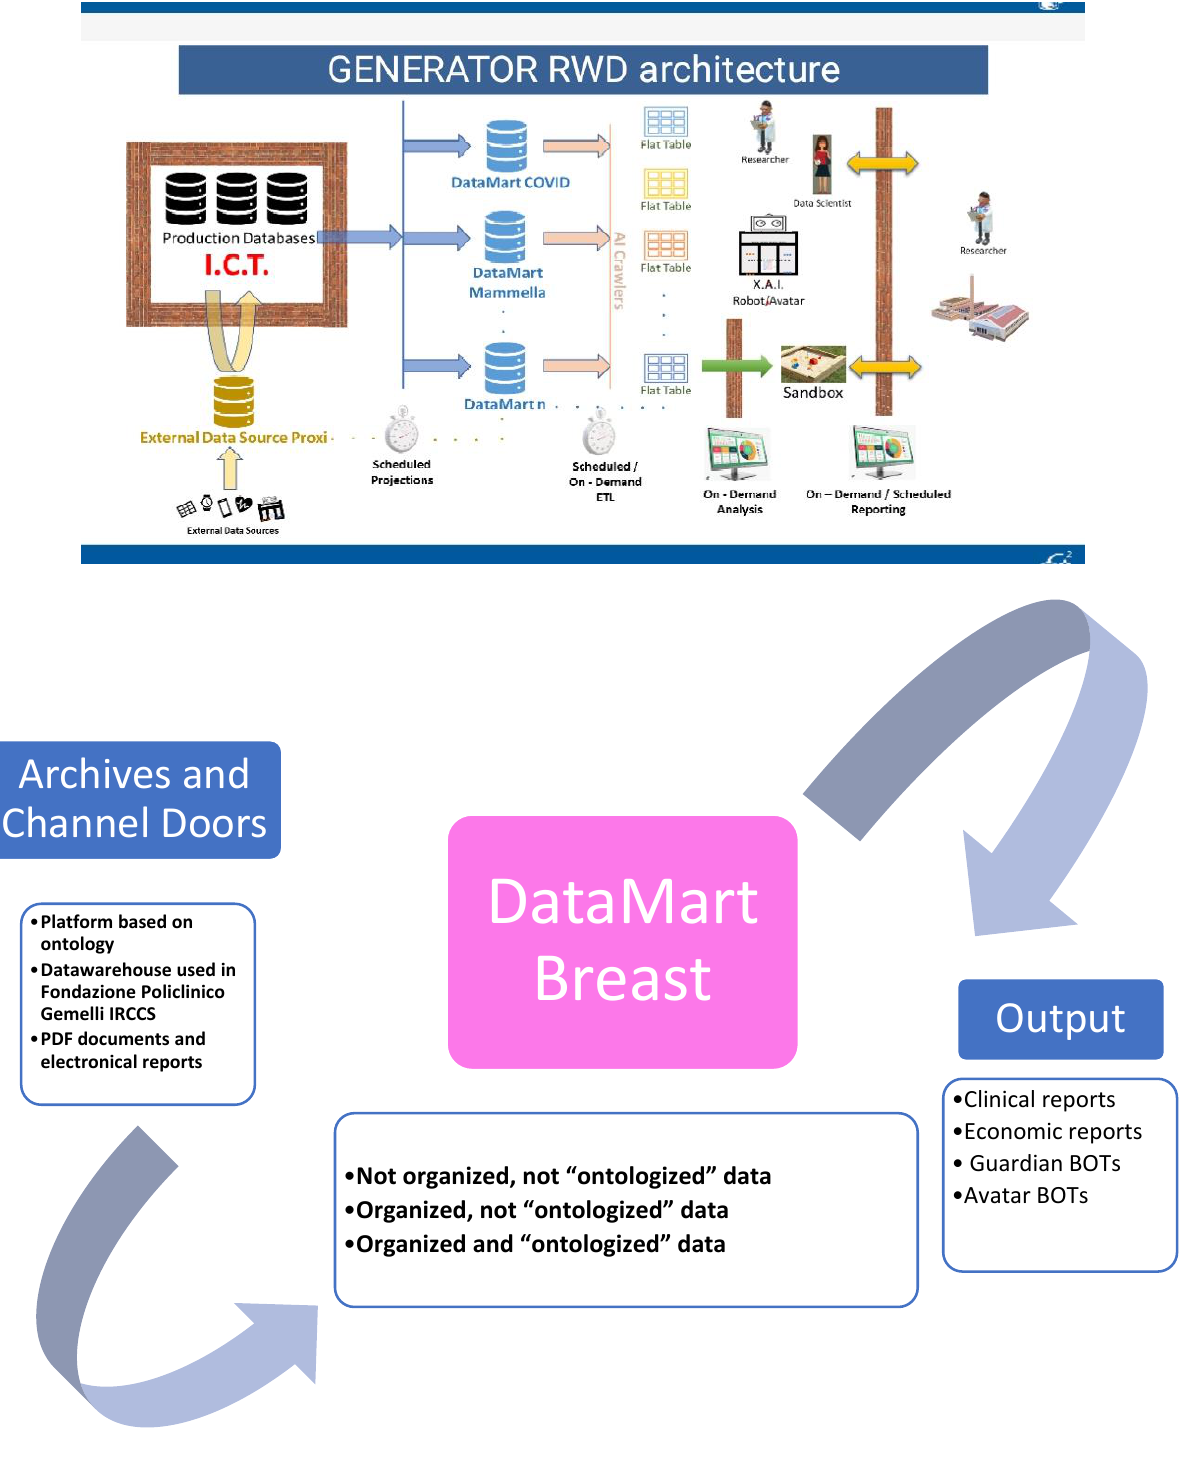
Figure 1. GENERATOR Breast DataMart architecture. In this figure, architecture of GENERATOR Breast DataMart is described. On the left, the sources are reported (a description is provided in Table 1). Thanks to Artificial Intelligence (AI) automatism, connection, and procedures, it is feasible to extract these data sources and deposit them inside Breast DataMart. An external server support Breast DataMart. Data extracted are available for further elaboration, such as creation of robots (or BOTs) for implementation of clinical research.